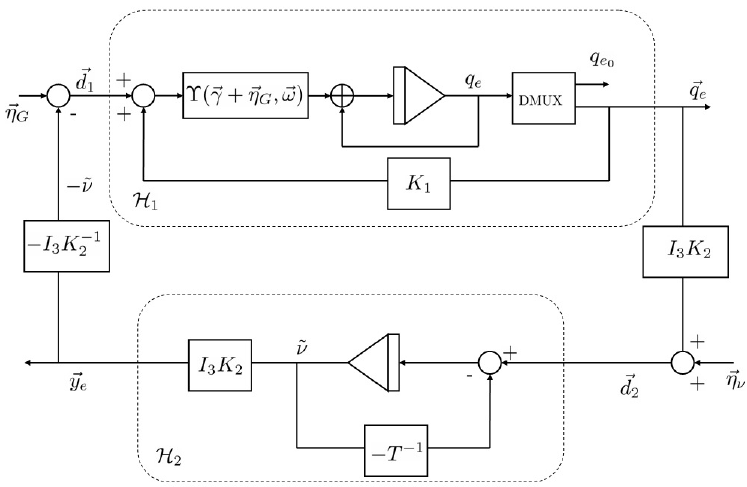
Figure 3. Block diagram of the dynamics of attitude and bias error with measurement